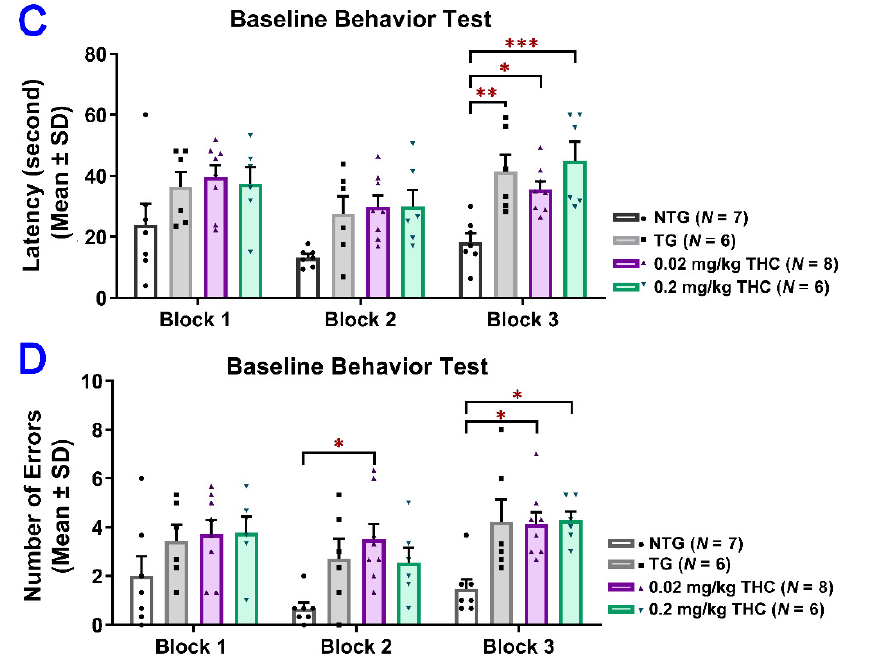
Figure 3. Evaluation of the baseline spatial reference memory of 14-month-old APP/PS1 mice in three study groups (i.e., the control transgenic control (TG), 0.02 mg/kg and 0.2 mg/kg THC treatment groups as well as 14-month-old non-transgenic (NTG) mice using the radial arm water maze (RAWM) test. Individual mice were subjected to five blocks of trials each day for three days with each block containing three trials. ( A ) No significant difference in baseline latency between male and female mice within individual study groups ( p = 0.56, p = 0.06, p = 0.51 and p = 0.947 for NTG, TG, 0.02 mg/kg and 0.2 mg/kg THC groups, respectively, using the Independent sample t test). ( B ) No significant difference in baseline number of errors between male and female mice within individual study groups ( p = 0.356, p = 0.299, p = 0.513, and p = 0.513 for NTG, TG, 0.02 mg/kg, and 0.2 mg/kg THC groups, respectively, using the Independent sample t test). ( C ) Significant increase in the baseline latency in TG ( p < 0.01), 0.02 mg/kg THC ( p < 0.05), and 0.2 mg/kg THC ( p < 0.001) groups compared with the NTG control group in Trial 3 of the last block on day 3. ( D ) Significant increase in the baseline latency in TG ( p < 0.01), 0.02 mg/kg THC ( p < 0.05), and 0.2 mg/kg THC ( p < 0.001) groups compared with the NTG control group in Trial 3 of the last block on day 3. Data are expressed as mean ± SD. SD is denoted by the error bars. A comparison of mean latency and number of errors between female and male animals in individual study groups was made with multiple t -tests with correction for multiple comparisons using the Holm–Sidak method. Comparison of mean baseline latency and number of errors among different study groups were conducted using one-way ANOVA with the post hoc Bonferroni’s multiple comparisons test. * p < 0.05, ** p < 0.01, and *** p < 0.001 compared between the control NTG ( N = 7), control TG ( N = 6), 0.02 mg/kg THC ( N = 8), and 0.2 mg/kg